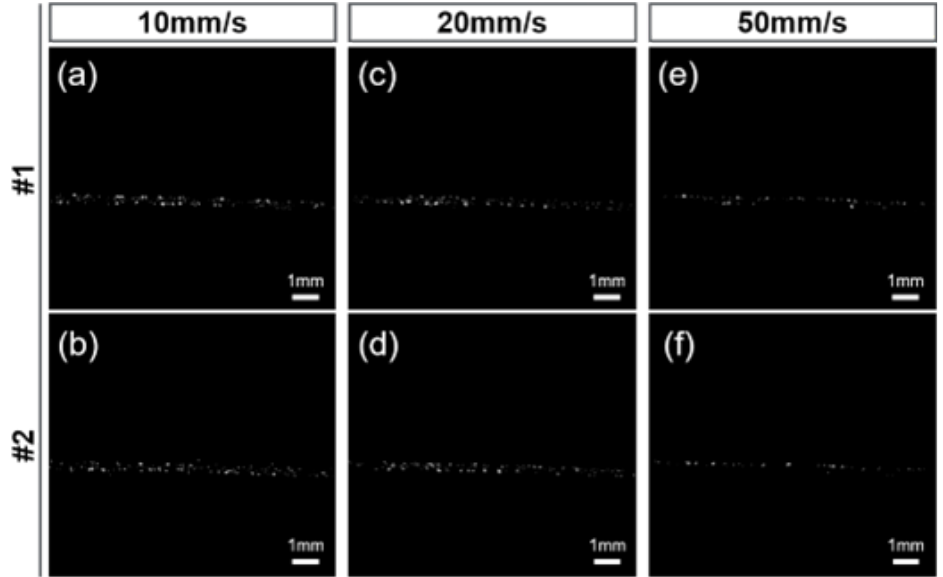
Figure 6. The examples of real-time B-mode imaging with three-frame difference algorithm under different flow velocities. Images at two different moments (#1, #2) were listed for each set of flow velocities. ( a , b ) 10mm/s, ( c , d ) 20mm/s and ( e , f ) 50mm/s.